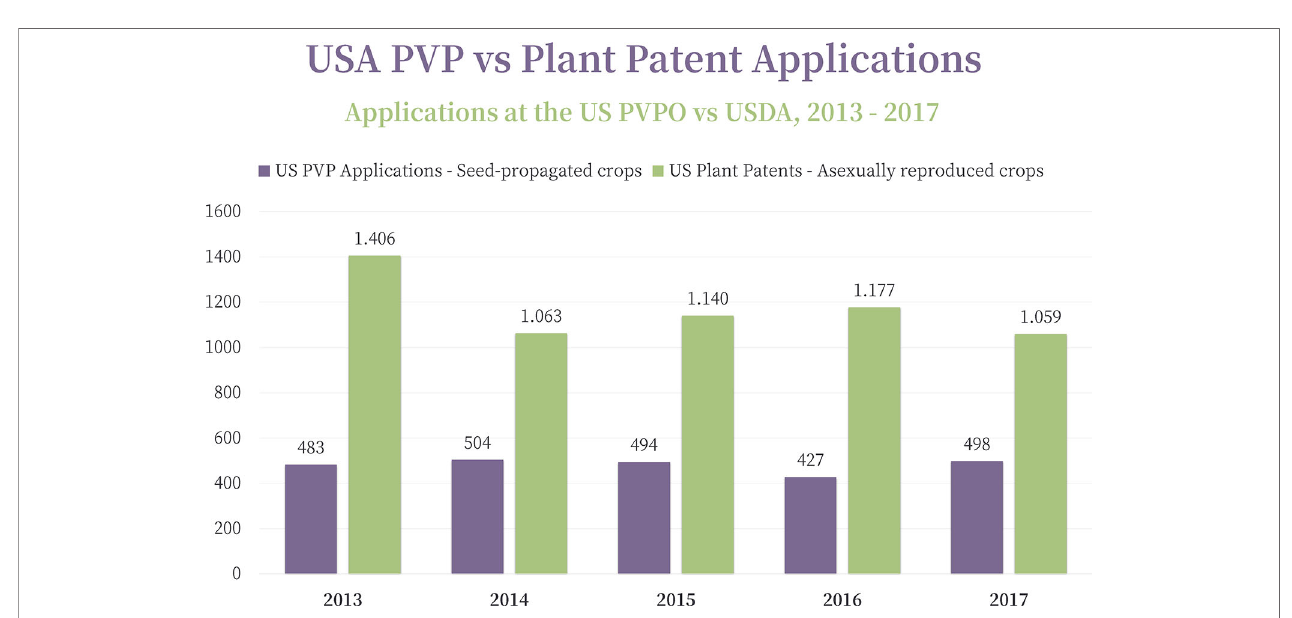
FIGURE 3 | Evolution of the U.S. Plant Variety Rights (PVP) vs. U.S. Plant Patent applications (2013 – 2017). Source: UPOV,